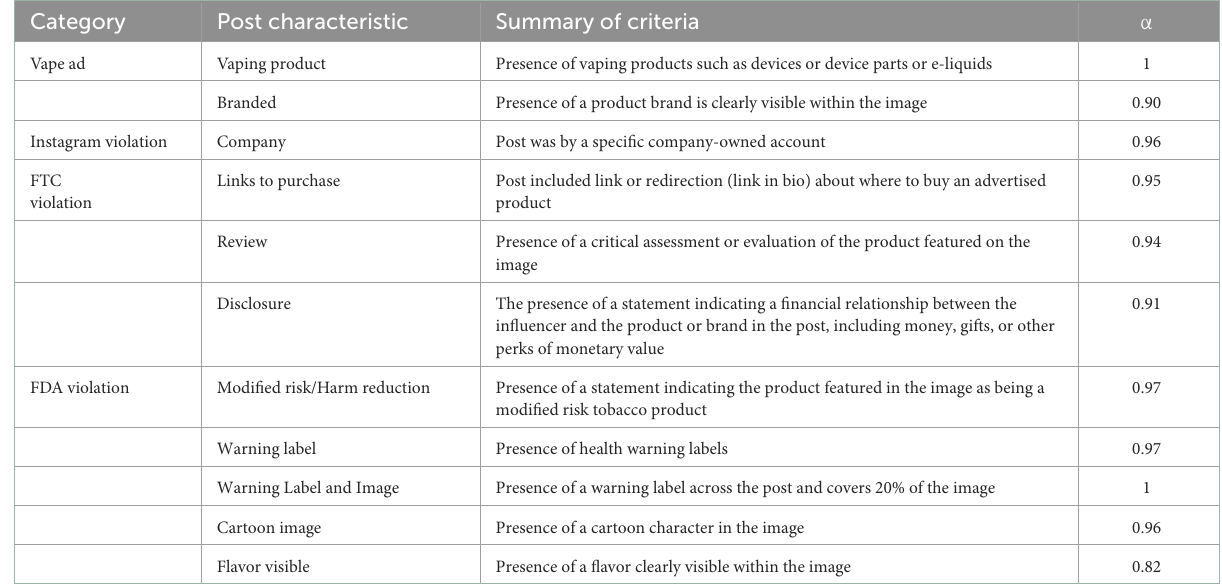
TABLE 1 Krippendorff’s alpha accessing reliability of coded post characteristics with summary of